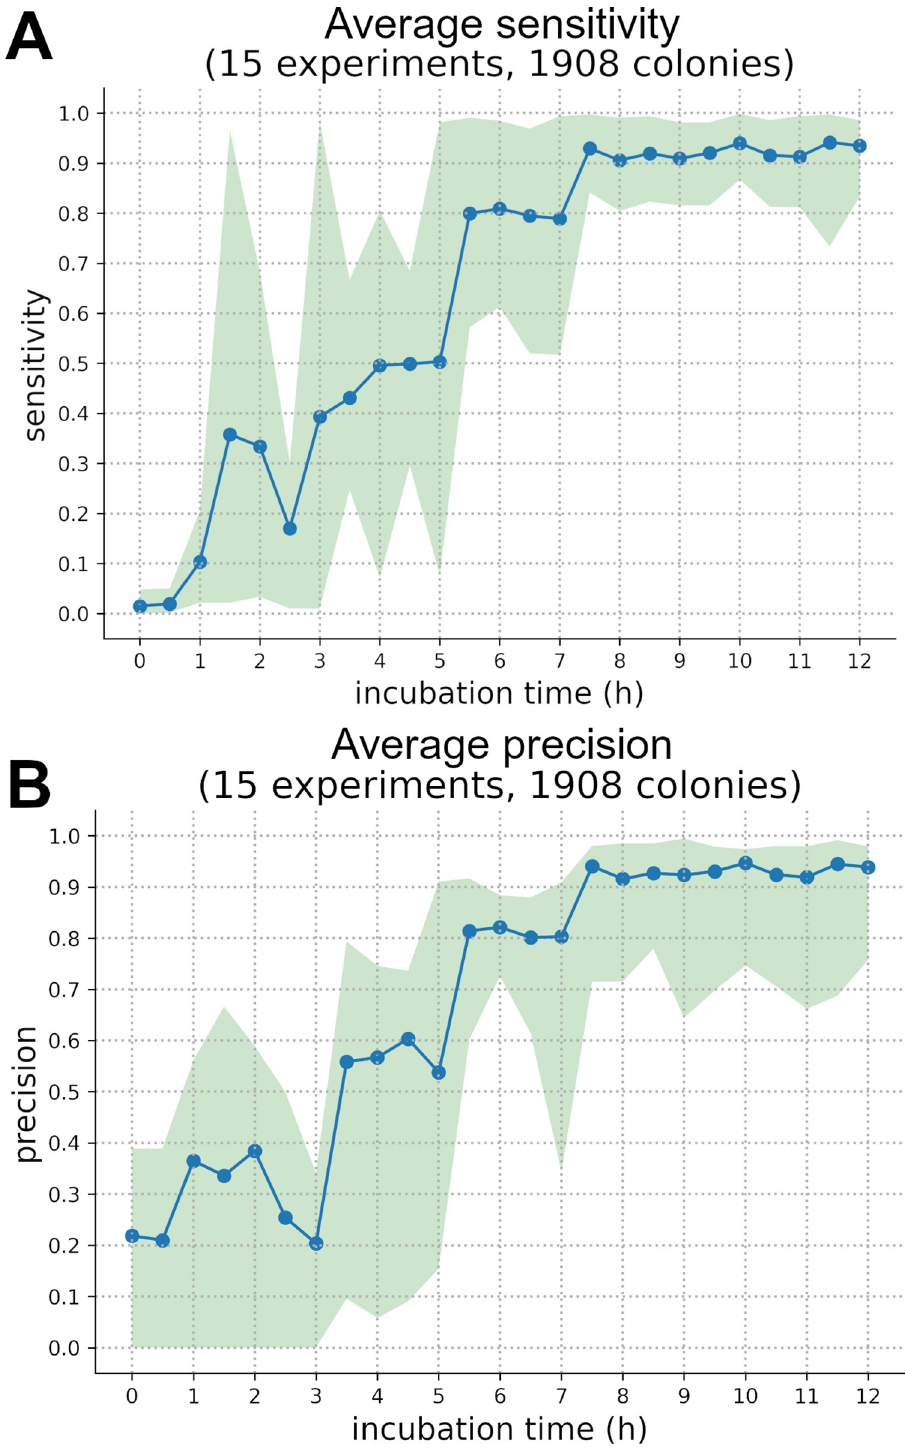
Fig 7. Classification phase average precision and sensitivity. Precision and sensitivity performance during the classification phase over a 12-hour incubation period on average. The green area represents the variation between the maximum and the minimum sensitivity for each time mark on all